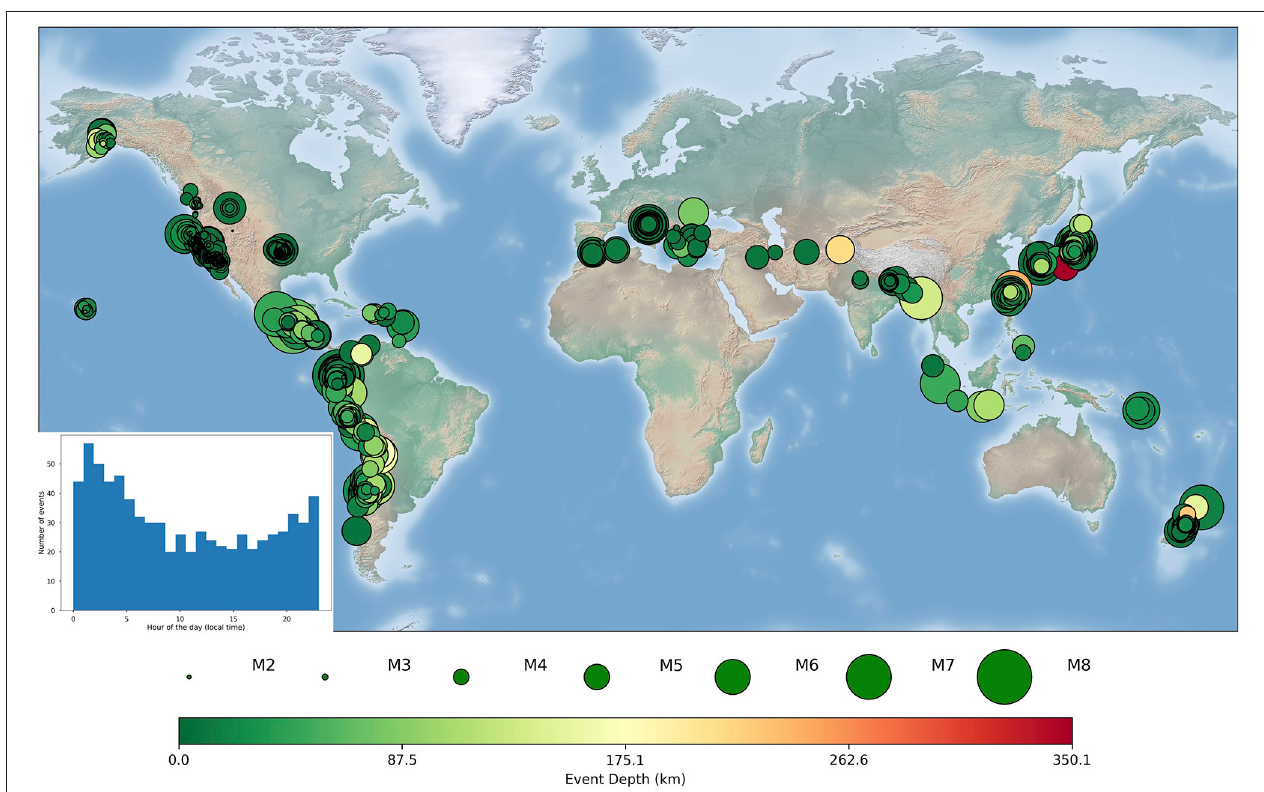
FIGURE 2 | Earthquakes recorded globally on the MyShake seismic network. The size of the disks represents earthquake magnitude M2-8 and are centered at the earthquake epicenter. The color of the disks denotes the event depth from 0 to 350km below the earth’s surface. Map data: NatGeo World Map. The histogram at the left bottom corner of the map is the local time hour of the events detected.